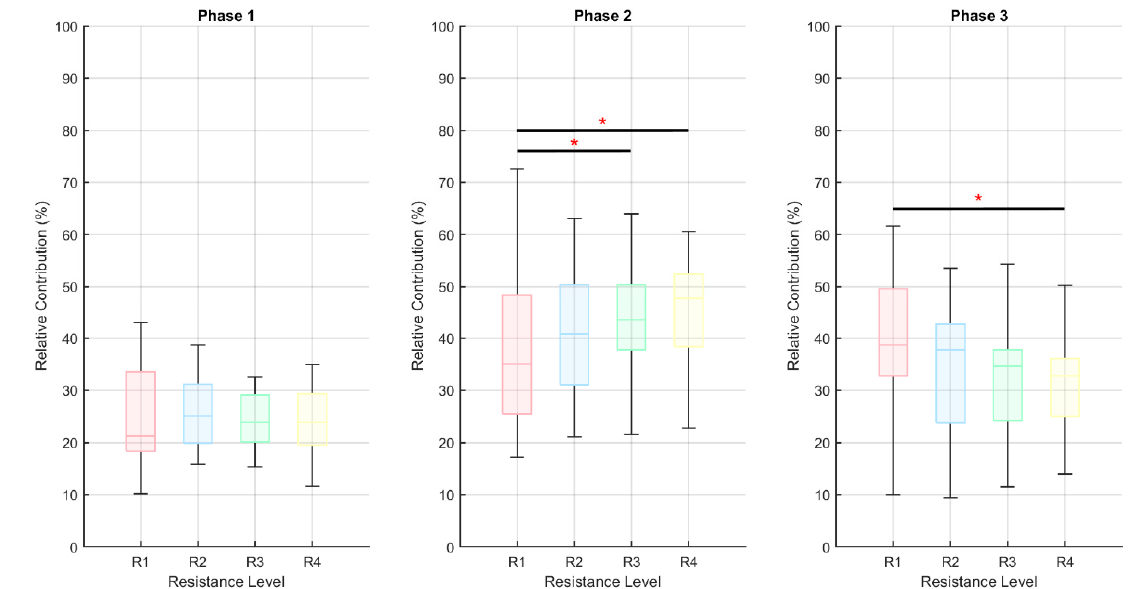
Figure 5. Comparison of the relative contribution of each phase depending on resistance level (*, p < 0.05). The relative contributions were computed based on Equation (3), and they represent the percentage of the total signal amplitude generated by each motion phase.